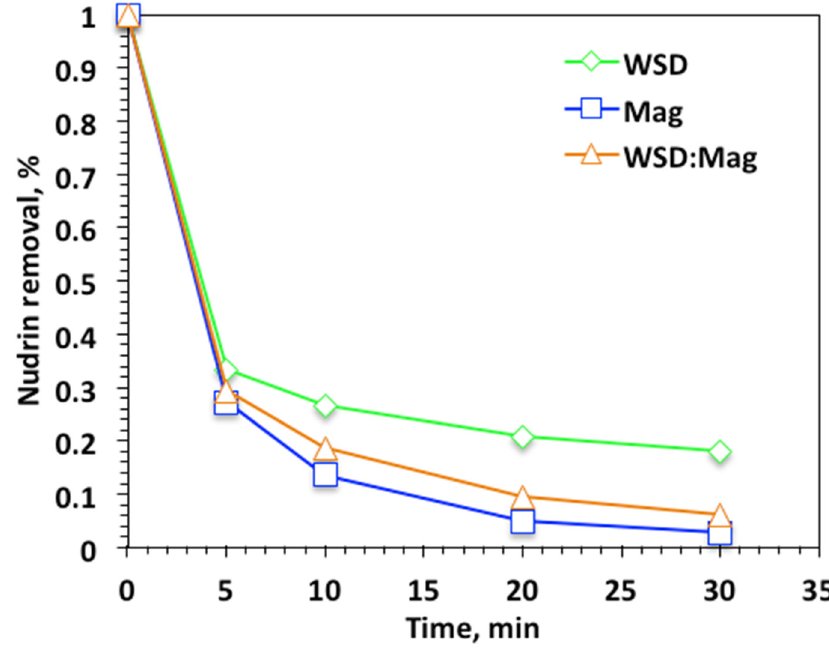
Figure 4. Effect of reaction time on photo-Fenton-like oxidationon different systems.